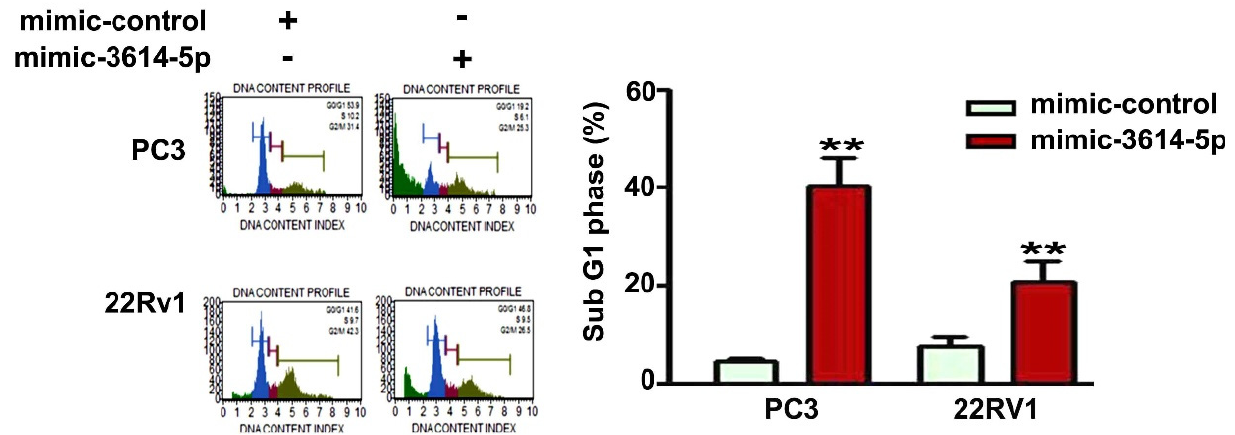
Figure 3. Effect of miRNA-3614-5p on cell cycle arrest in human PC3 and 22Rv1 prostate cancer cells. Regulation of cell cycle distribution in human PC3 and 22Rv1 prostate cancer cells transfected with mimic-control or mimic-3614-5p were analyzed by using PI staining through flow cytometry. Cells transfected with mimic-control as the control group. **, p < 0.01 versus control (mean ± SE, n = 3). DNA content index (x-axis): analyzes the cell populations in each phase of the cycle (sub G1, G0/G1, S, G2/M phase); DNA content (y-axis): measures the percentage of cells in each cell cycle phase. Sub-G1: apoptotic cells. Mimic-3614-5p as mimic miRNA-3614-5p